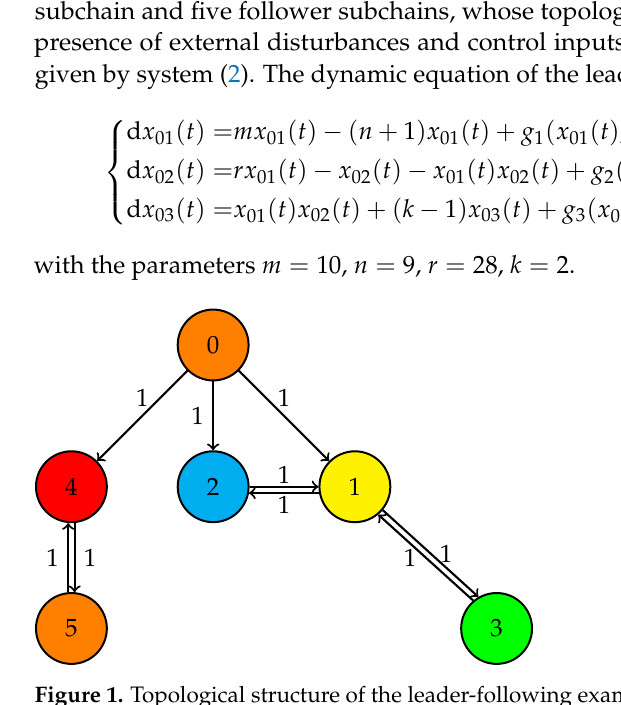
Figure 1. Topological structure of the leader-following